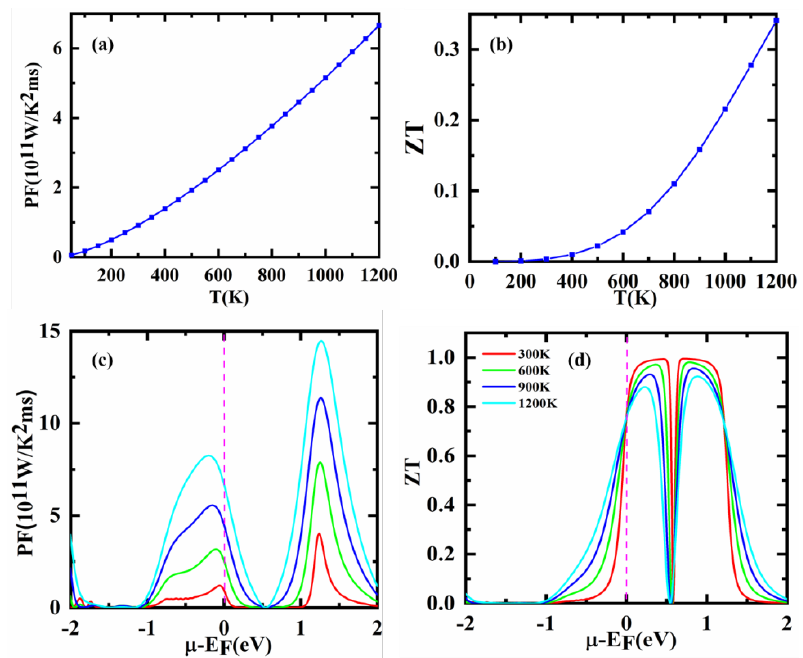
Figure 9. ( a ) Power factor, ( b ) ZT vs. temperature, ( c ) power factor, and ( d ) ZT chemical potential of cubic obtained using the nmBJ-GGA method. cubic obtained using the nmBJ-GGA